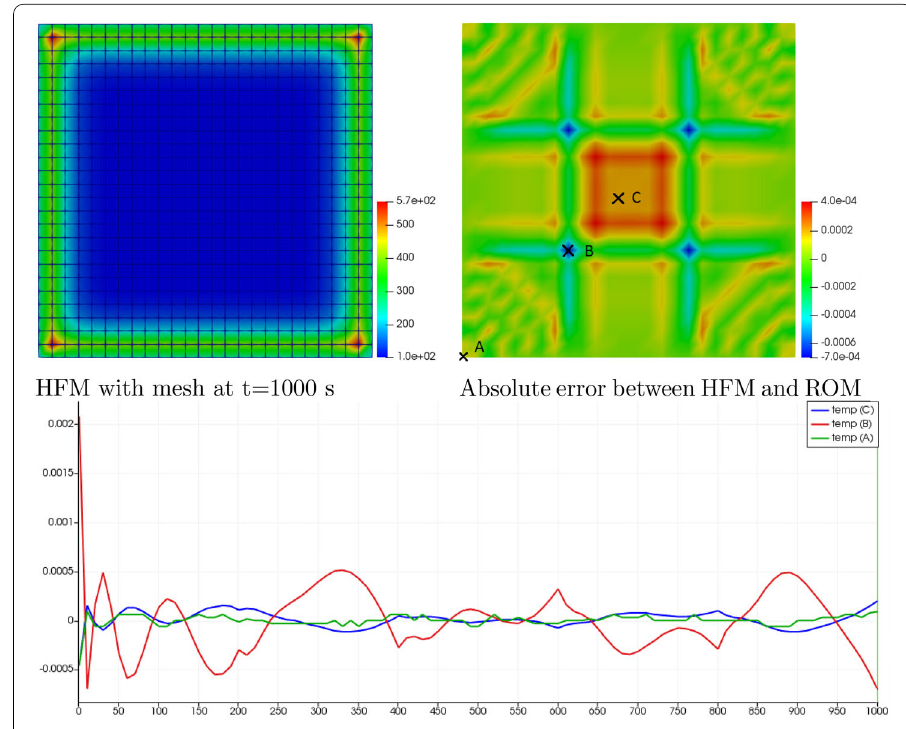
Fig. 4 Simple test case with convection only using Z-set